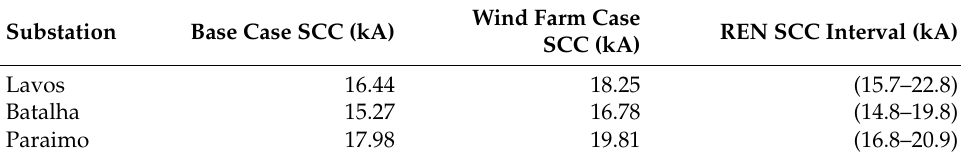
Table 9. Short circuit current calculation in Portugal: comparison with REN